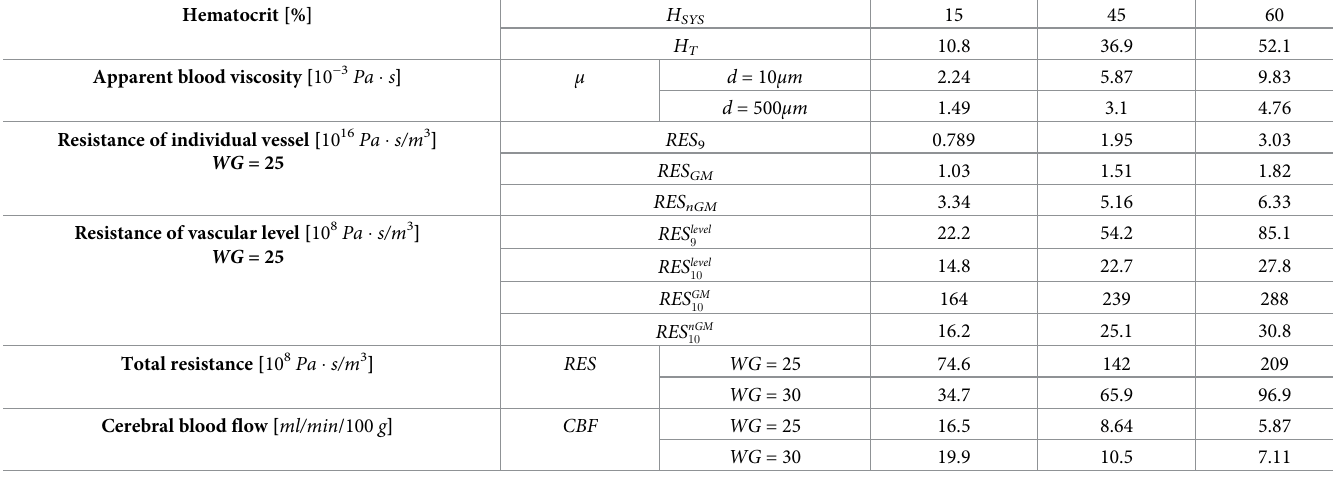
Table 2. Dependence of computed model parameters on